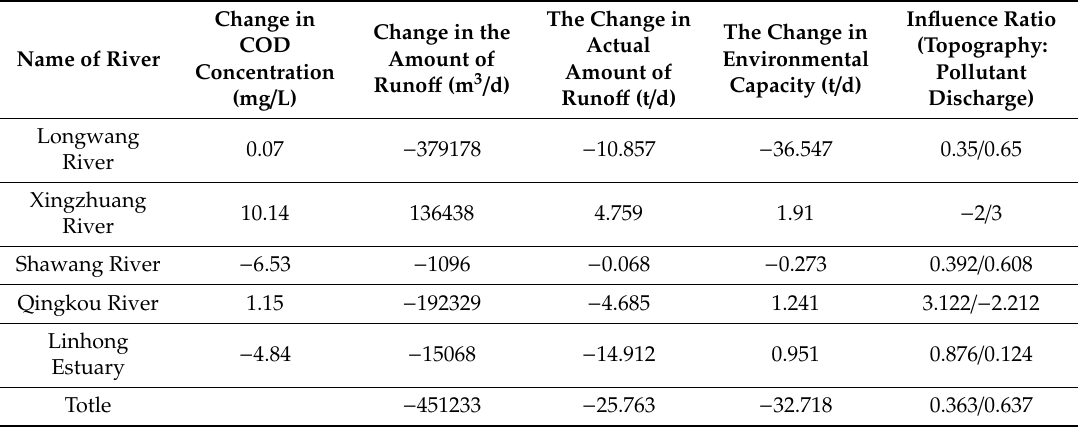
Table 9. The changes in conditions and environmental capacity in the coastal estuaries of Haizhou Bay from 2006 to